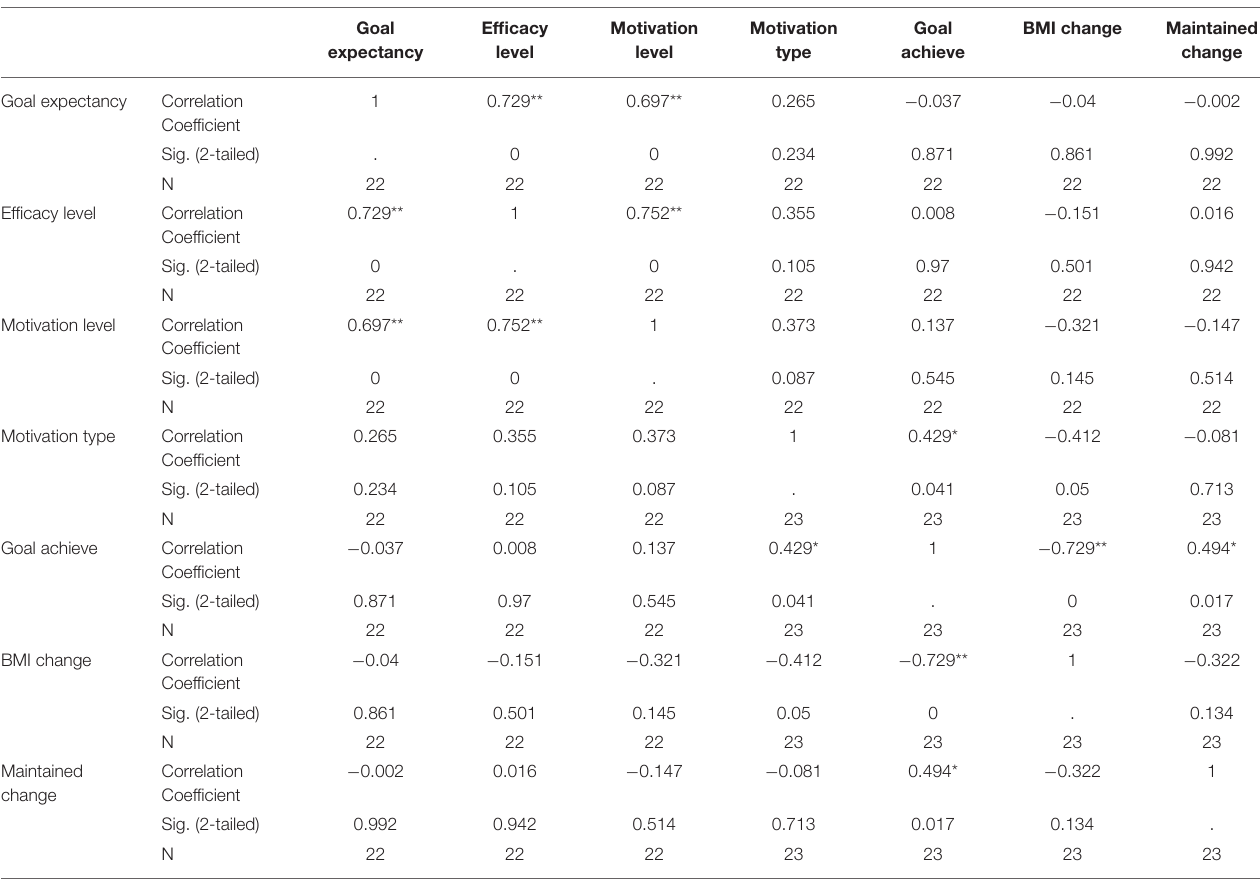
TABLE 3 | Correlation measurements (Spearman’s